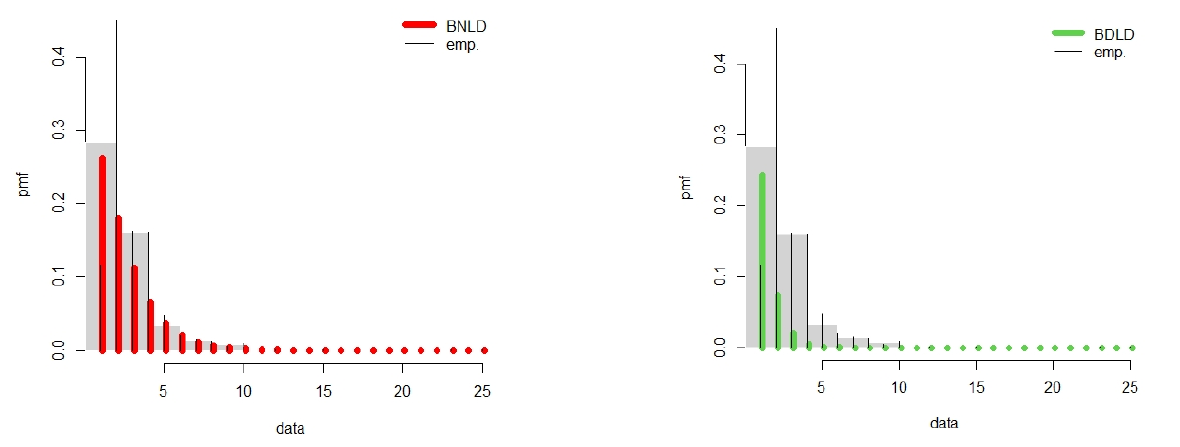
Figure 9. Fitted plots of BNDL and BDLD distribution for given data set.